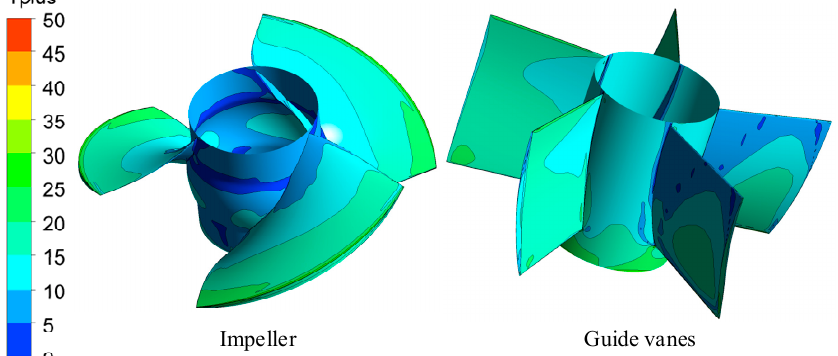
Figure 7. The Yplus distribution of computational domain.